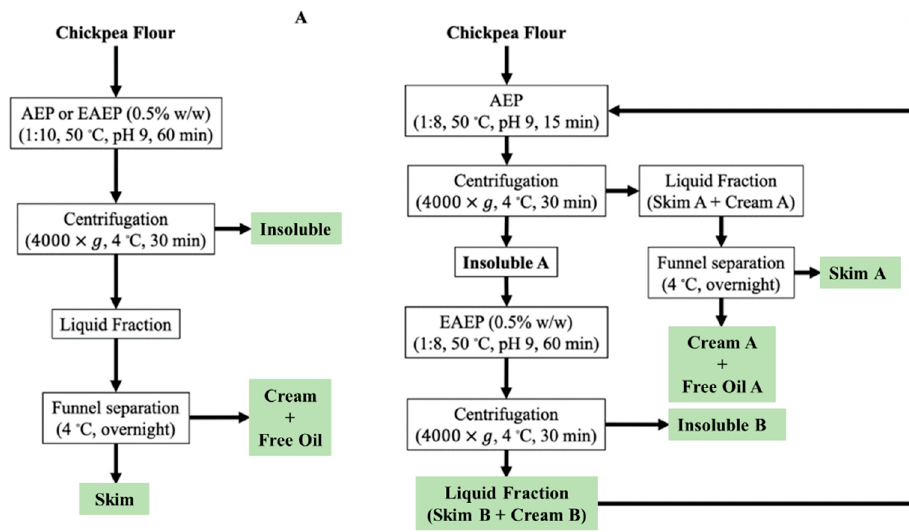
Figure 1. Simplified processing schematic of the single-stage ( A ) and two-stage ( B ) countercurrent EAEP of full-fat chickpea flour.